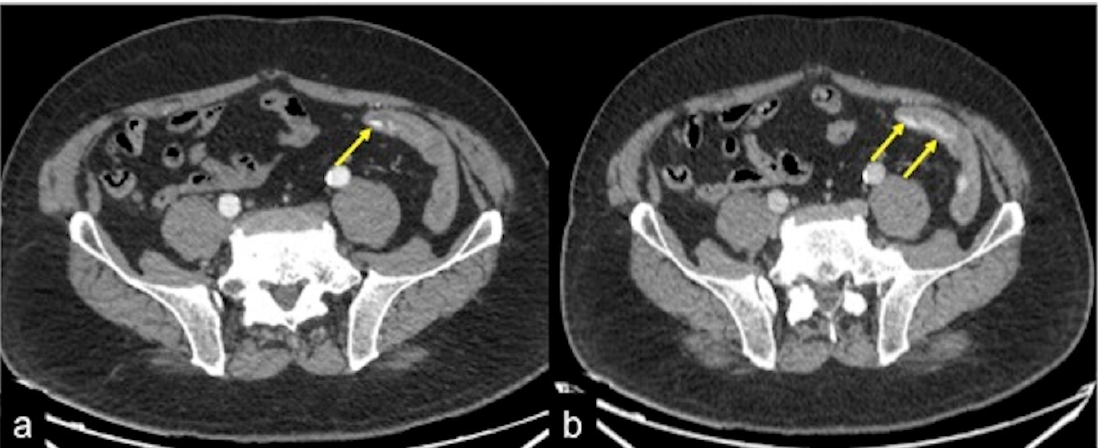
Figure 3. CT multiphasic study of bleeding at the proximal tract of sigma. In the arterial axial image after contrast media administration ( a ) it is possible to detect a blush of active bleeding (arrow). In the venous phase ( b ) a dimensional increase of the hyperdense blush is present (arrows) as a sign of active incremental bleeding in the venous phase.